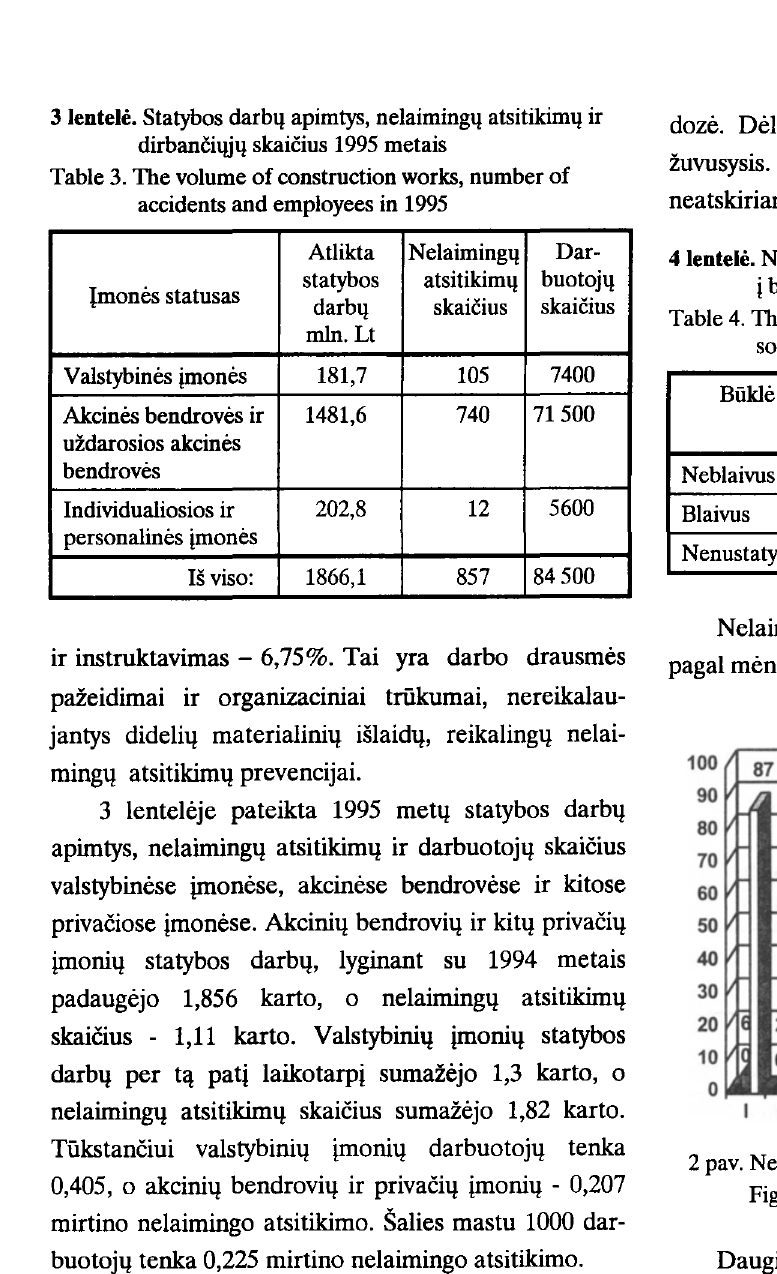
Fig. 2. The distribution of accidents in 1995 Daugiausia nelaimingq atsitikimq ivyko lapkricio (mirtinq - 4, sunkiq - 5, lengvq - 93) ir ziemos mene siais: slidumas bei nepalankesnes meteorologines mingq atsitikimq skaiCius pagal traumavimo veiksnius. Pagal nelaimingq atsitikimq skaiCiq pavojingiau sios dirbanciqjq statybose profesijos yra pagalbiniai darbininkai, murininkai ir dailides, suvirintojai ir